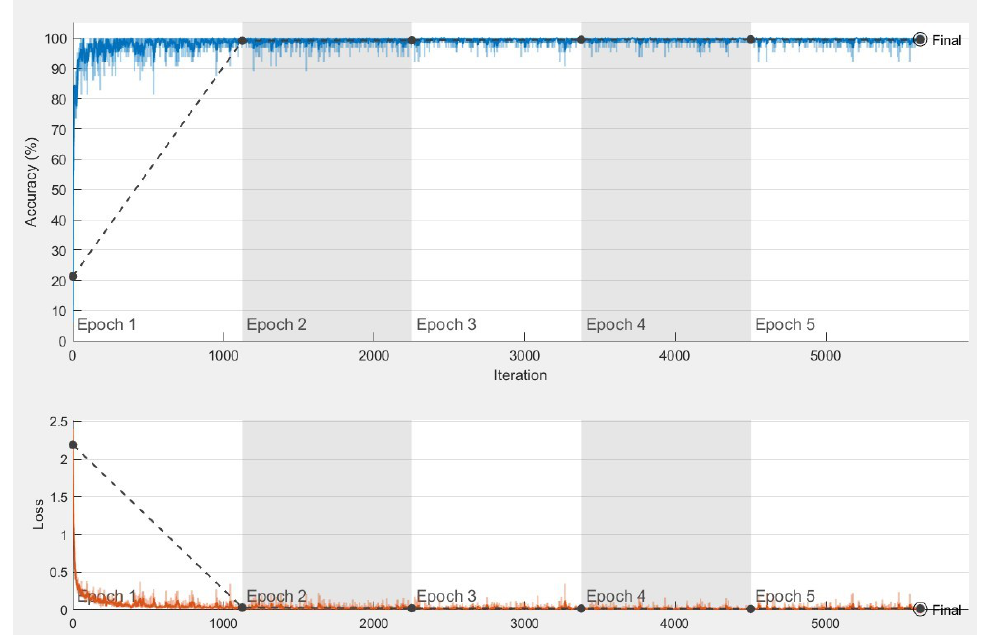
Figure 7. VB-DCNN Training for Case-III.